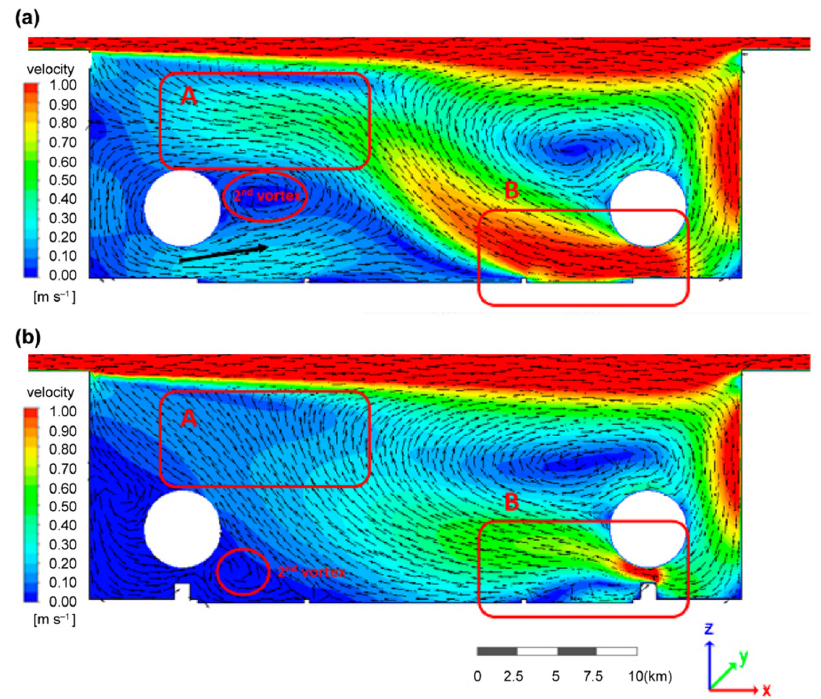
Figure 5. Comparative velocity analysis for single- and multi-layer vegetation structures: ( a ) E1 and ( b ) E2. ( a ) describes the flow in the horizontal direction due to the generation of a second vortex below zone A and the large flow in zone B. ( b ) shows that a second vortex was not generated in zone A, resulting in vertical flow and reduced flow in zone B.